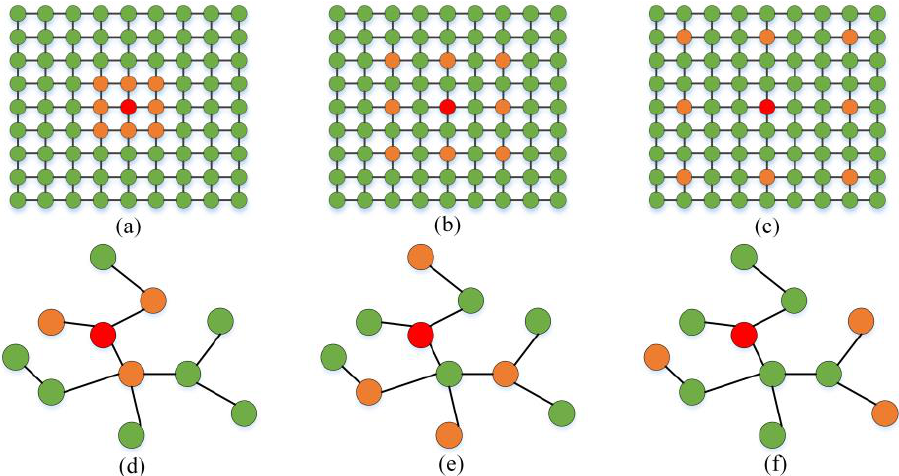
Figure 3. The red node means the central node. The orange node represents the node aggregated. ( a – c ): 3 × 3 dilated convolution, with dilated rates of 1, 2, and 3 from left to right; ( d – f ): k-dilated graph convolution, with k values of 1, 2, and 3 from left to right. The dilated graph convolution enlarges the receptive field.